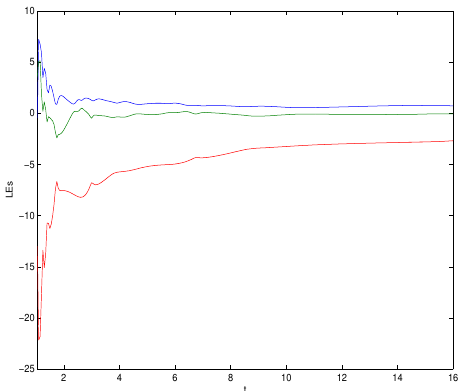
Figure 5. Lyapunov exponent dynamics from a Chen system (24).